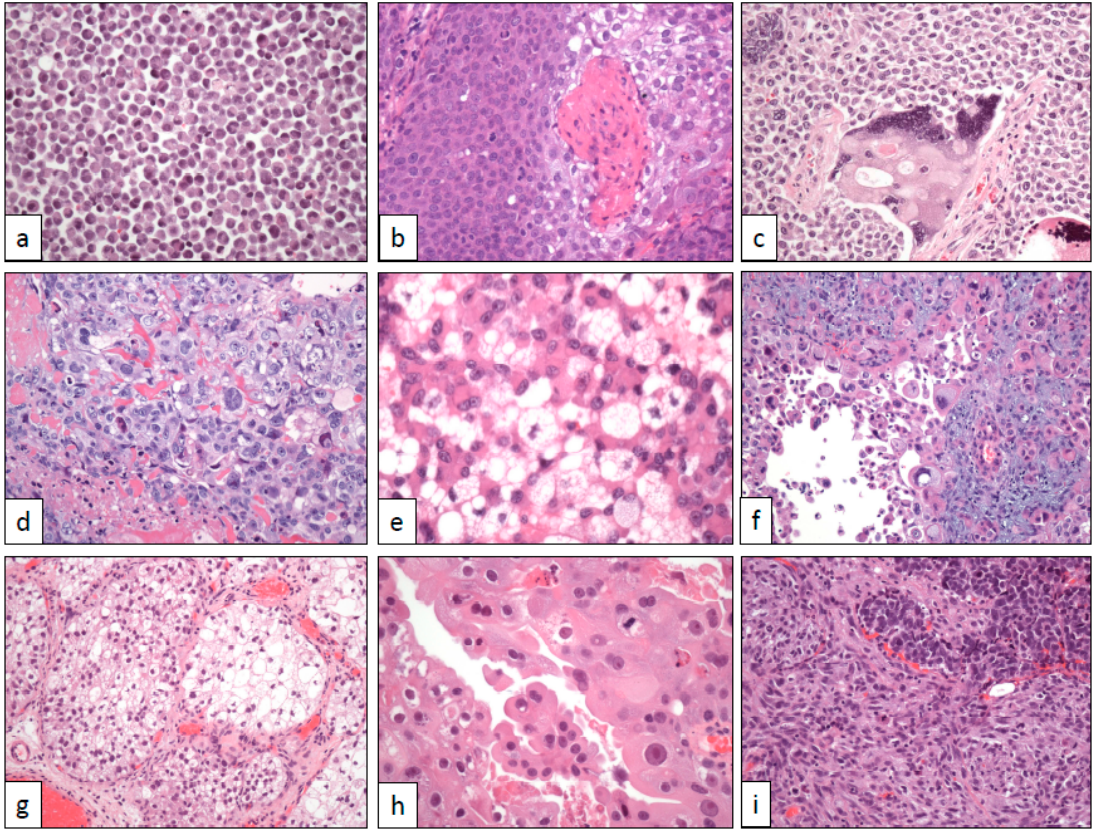
Figure 2. Cytological changes in bladder cancer. ( a ) Plasmacytoid cells (×250), ( b ) basaloid and squamous cells (×250), ( c ) syncytiotrophoblastic cells (×250), ( d ) trophoblastic cells (×250), ( e ) lipoblastic-like cells (×400), ( f ) pleomorphic giant cells (×250), ( g ) clear cells (×100), ( h ) eosinophilic (oncocytoid) cells (×400), and ( i ) sarcomatoid cells (×250).